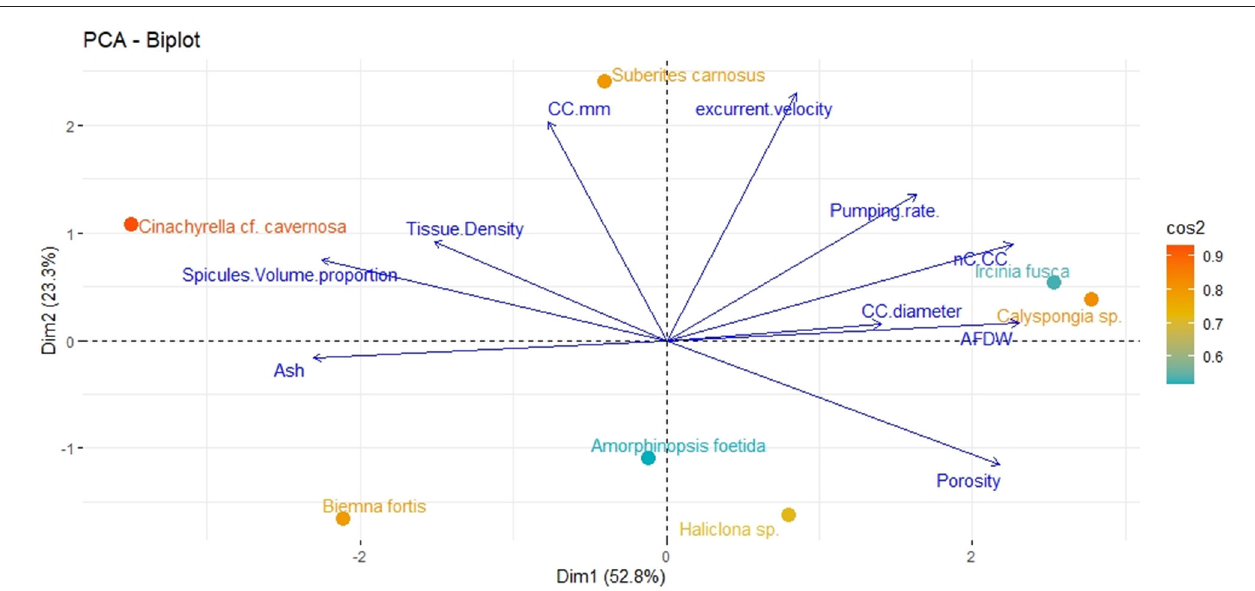
FIGURE 2 | Principal components analysis Dim1 (PCA1) and Dim2 (PCA2) of the combination of structural, filtration, and pumping variables indicating the position of the studied sponge species on a plane defined by the first two axes. Arrows indicate the direction of factor loadings on axes 1 and 2.